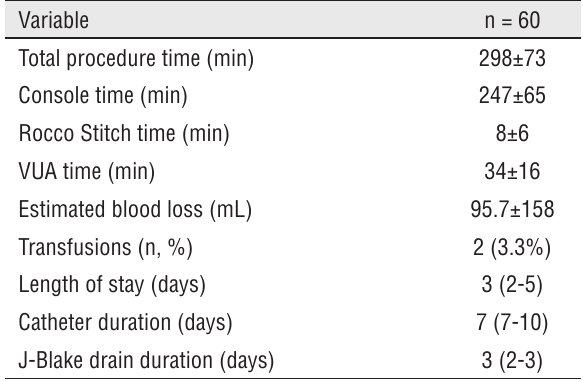
Table 3 - perioperative outcomes.